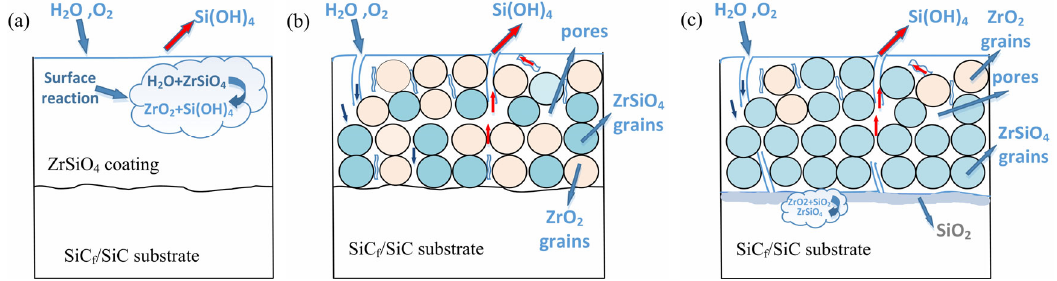
Fig. 9 Corrosion recession mechanism of ZrSiO 4 coating in water vapor corrosion environment: (a) initial stage of volatilization, (b) pores and a large amount of ZrO 2 grains appear in the surface layer, and (c) late in the corrosion